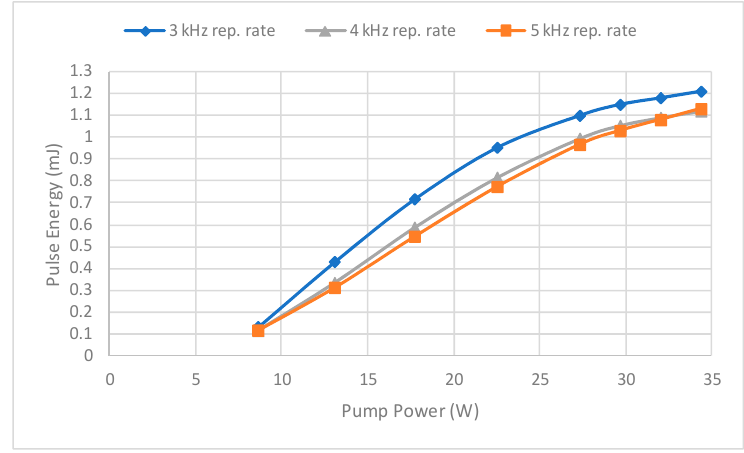
Figure 5. Energy vs. pump power 3–5 kHz repetition rate results.